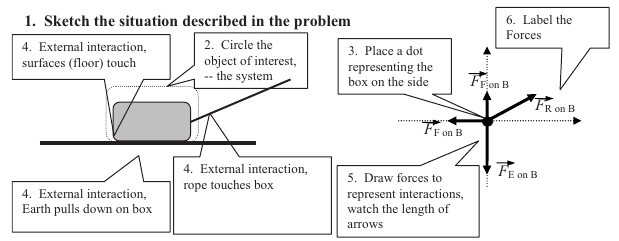
FIG. 2. Picture, free-body diagram and steps in how to construct FBDs (cid:1) Ref. 45 (cid:1) 5 (cid:2) Draw force arrows that represent the external interac- tions that affect the behavior of the system object. Draw the tails of these force arrows beginning on the particle dot. Draw the lengths of the arrows to represent the relative mag- nitudes of the forces. (cid:1) 6 (cid:2) Label the forces in the diagram with two subscripts identifying two interacting objects. Note: The forces in the diagram should represent the force that some object outside the system exerts on the object inside the system. To start, identify the external object that causes each force and also the object on which the force is exerted.